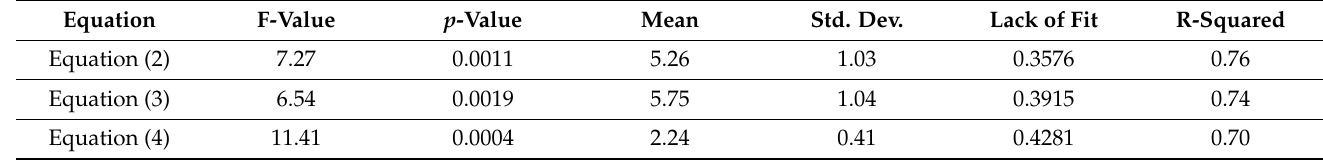
Table 8. Summary of ANOVA results for the three regression